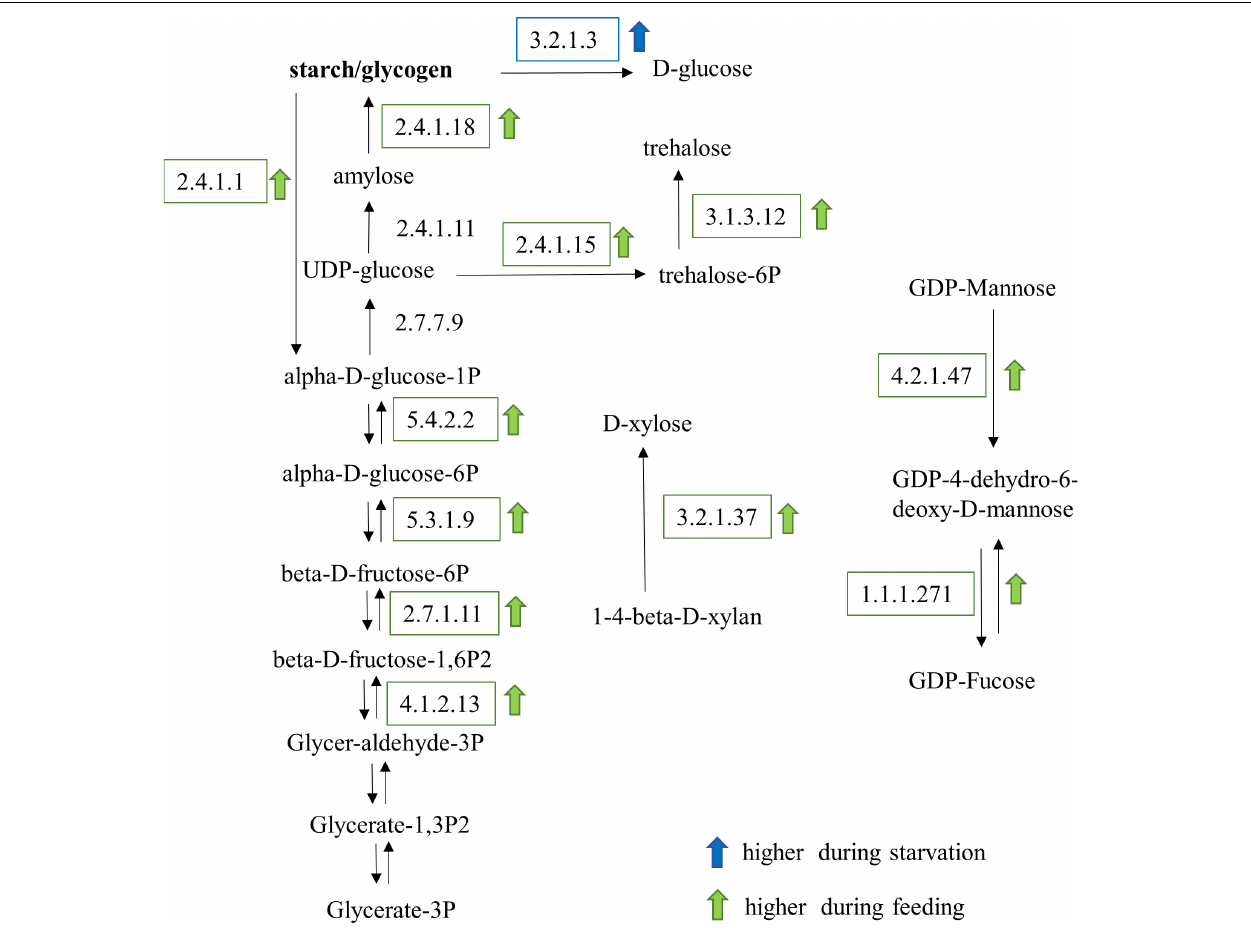
FIGURE 7 | Carbohydrate metabolic pathways affected by the feeding and starvation state in O. marina cells. Arrows and boxes indicate significantly differentially expressed transcripts in either the fed (green) or starved (blue)